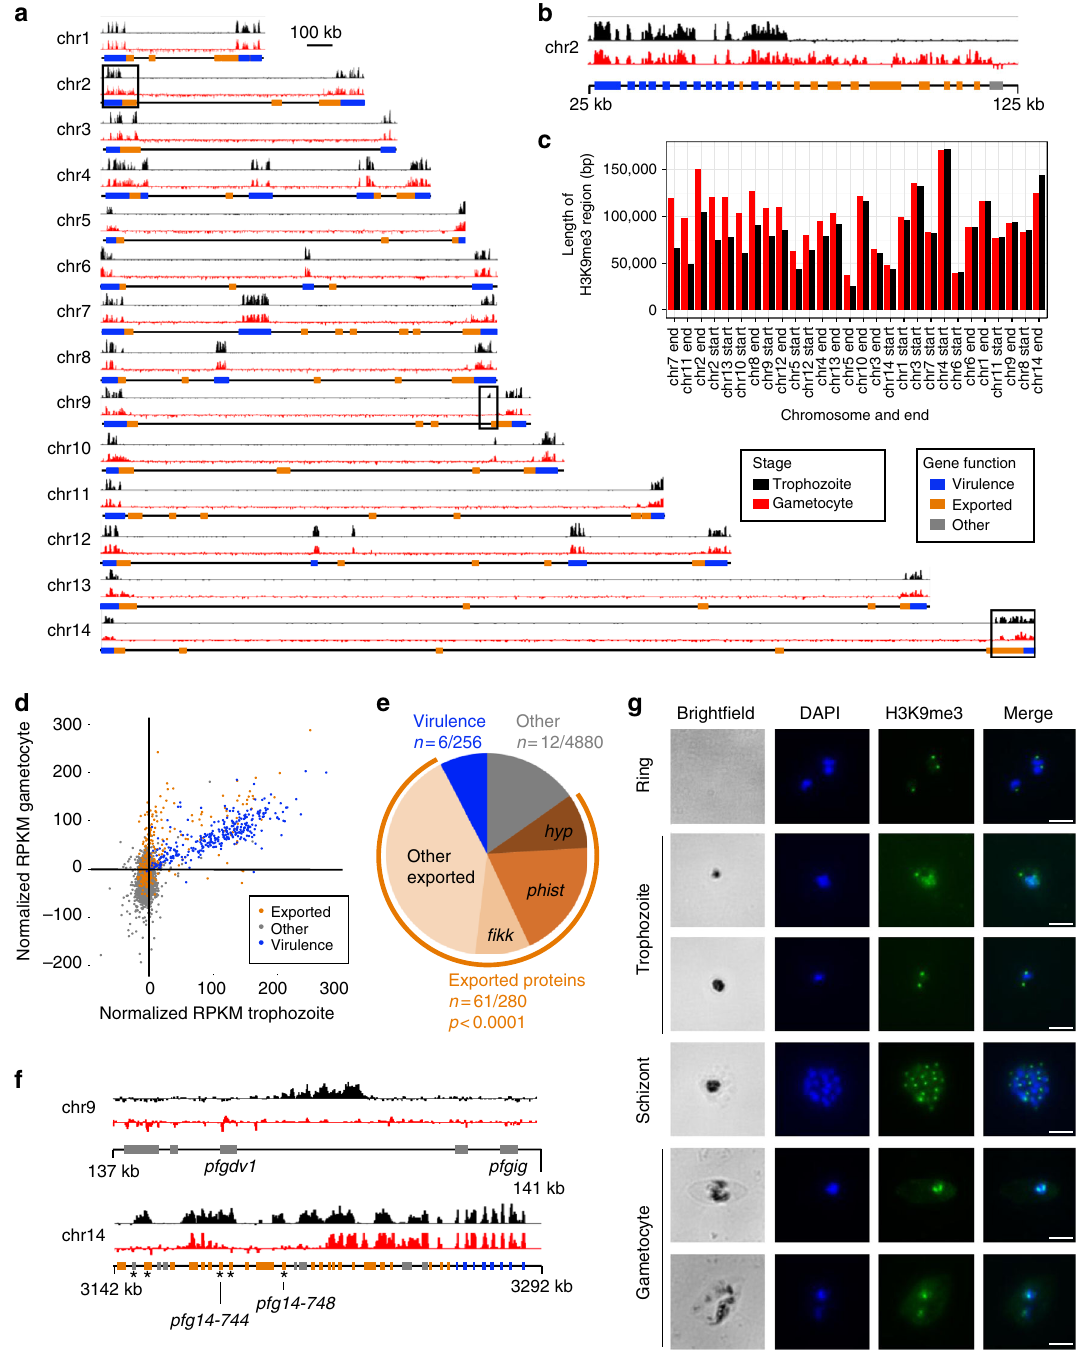
Fig. 3 Silencing of genes encoding exported proteins in gametocytes through expansion of heterochromatin. a ChIP-seq analysis of genome-wide H3K9me3 localization in trophozoites (top tracks in black) and stage IV/V gametocytes (bottom tracks in red). Results of one representative biological replicate are shown for each stage. Results for a second biological replicate are shown in Supplementary Fig. 11. The regions depicted in panels B and F are indicated with black boxes. b Expansion of H3K9me3 heterochromatin in gametocytes as compared to trophozoites, predominantly to genes encoding exported proteins. c Length of each subtelomeric region in which the majority of genes is marked by H3K9me3, sorted by the difference in length between these regions in trophozoites and gametocytes. d H3K9me3 levels per gene at the trophozoite and gametocyte stages. e Enrichment of genes encoding for exported proteins among genes with increased levels of H3K9me3 in gametocytes ( p -value from a two-tailed Fisher ’ s exact test). f Loss of H3K9me3 mark in gametocytes on chromosome 9 between gametocyte development genes pfgdv1 and pfgig , as well as at gametocyte-speci fi c genes encoding exported proteins on chromosome 14 (indicated with an asterisk). g Immuno fl uorescence analysis showing a single H3K9me3 focus in ring and schizont stages, and either one or two foci in gametocytes. Scale bar denotes 1 μ